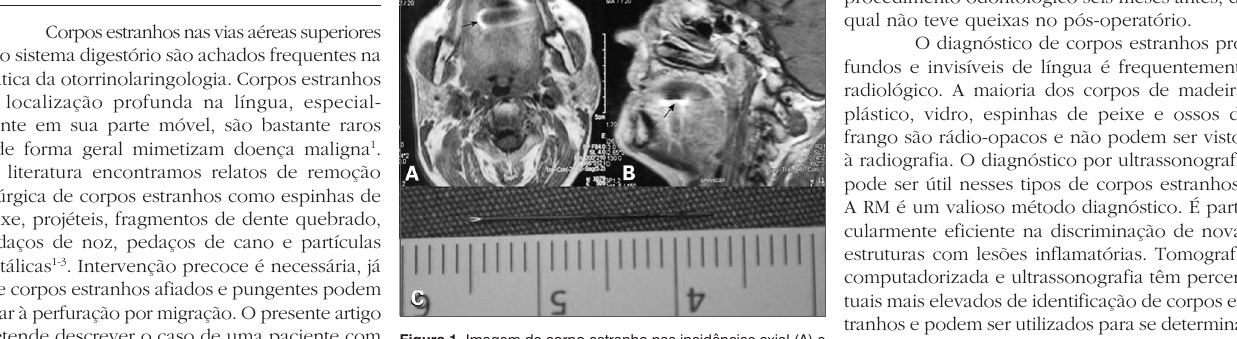
Figura 1. Imagem de corpo estranho nas incidências axial (A) e sagital (B) nas imagens por RM (seta preta). Imagem da agulha odontológica removida